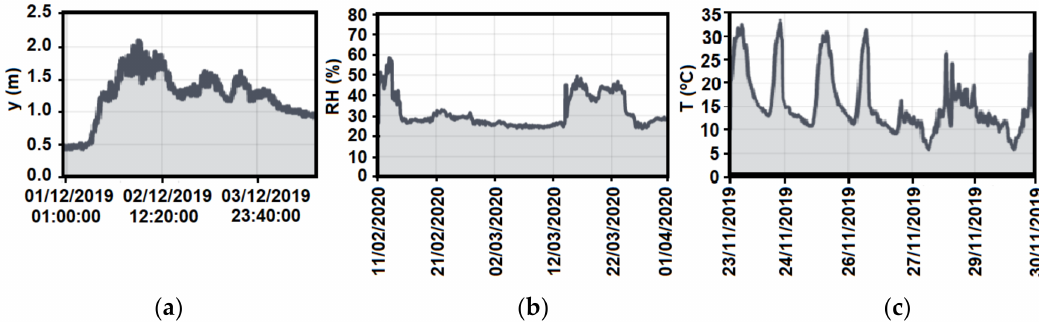
Figure 9. Hydrologic monitoring system data at different times, as shown on the Web platform: ( a ) water depth, ( b ) relative humidity, and ( c ) air temperature.